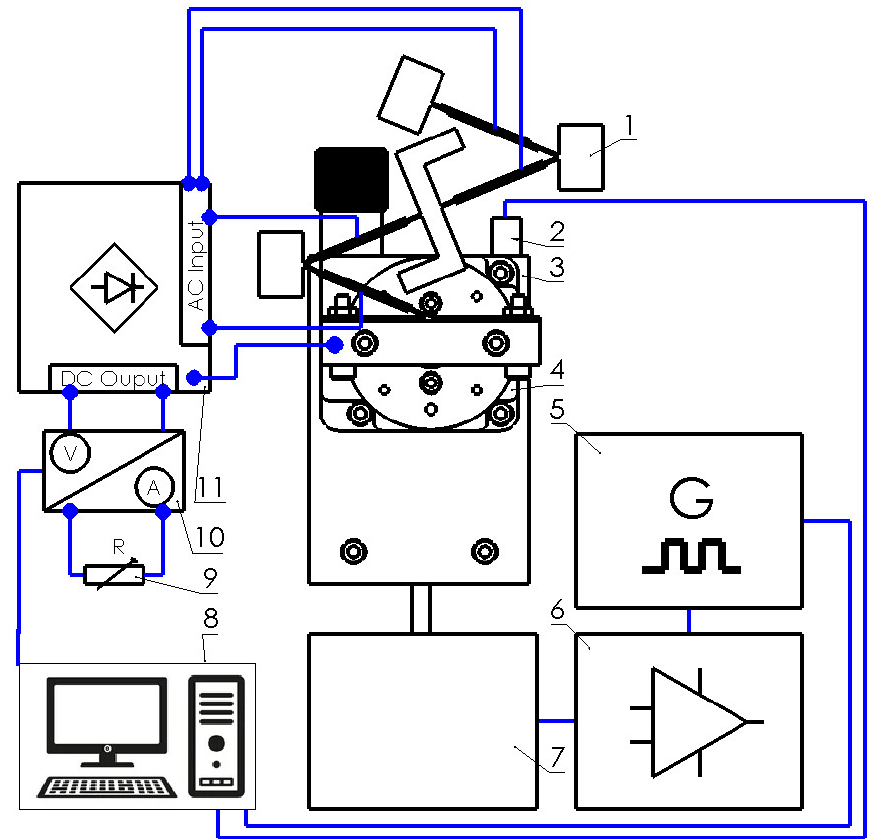
Figure 13. Experimental setup; 1—energy harvester, 2—accelerometer; 3—clamping of energy harvester; 4—rotatable table; 5—function generator; 6—power amplifier; 7—electromagnetic shaker; 8—computer; 9—variable resistor; 10—two channel multimeters; 11—AC/DC converter.